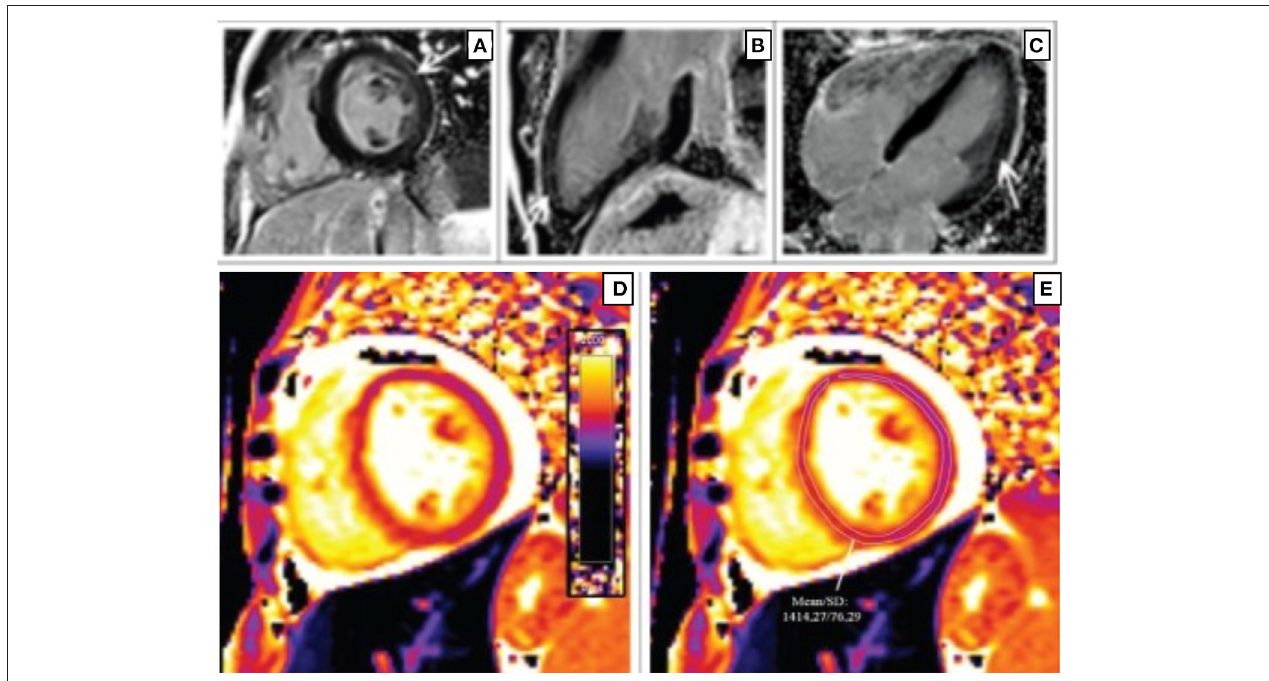
FIGURE 1 | Short-axis (A) , 2-chamber (B) , and 4-chamber (C) late gadolinium phase-sensitive inversion recovery images show linear mid-wall enhancement in the lateral wall of the LV (white arrows) in a patient with HIV. T1 map at the level of the mid-LV (D) shows a markedly elevated myocardial T1 time of 1,414 m/s (normal 1,052 m/s ± 23 m/s at 3T) (E) consistent with diffuse myocardial fibrosis (